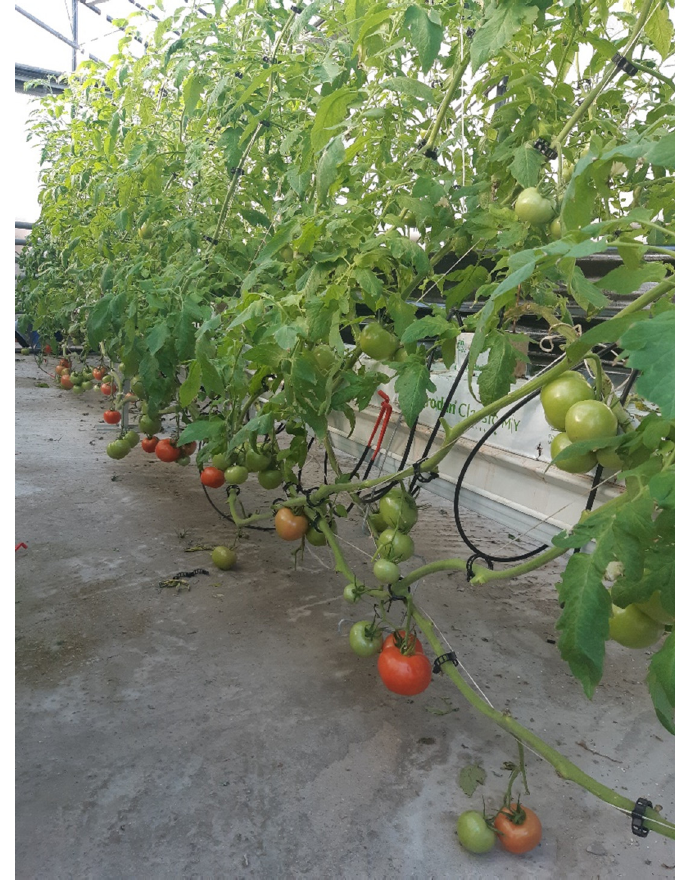
Figure A1. Tomato plants with ripe fruits at 97 DAT.